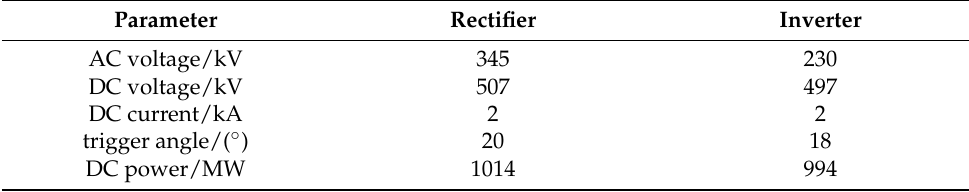
Table 1. Test system parameters.